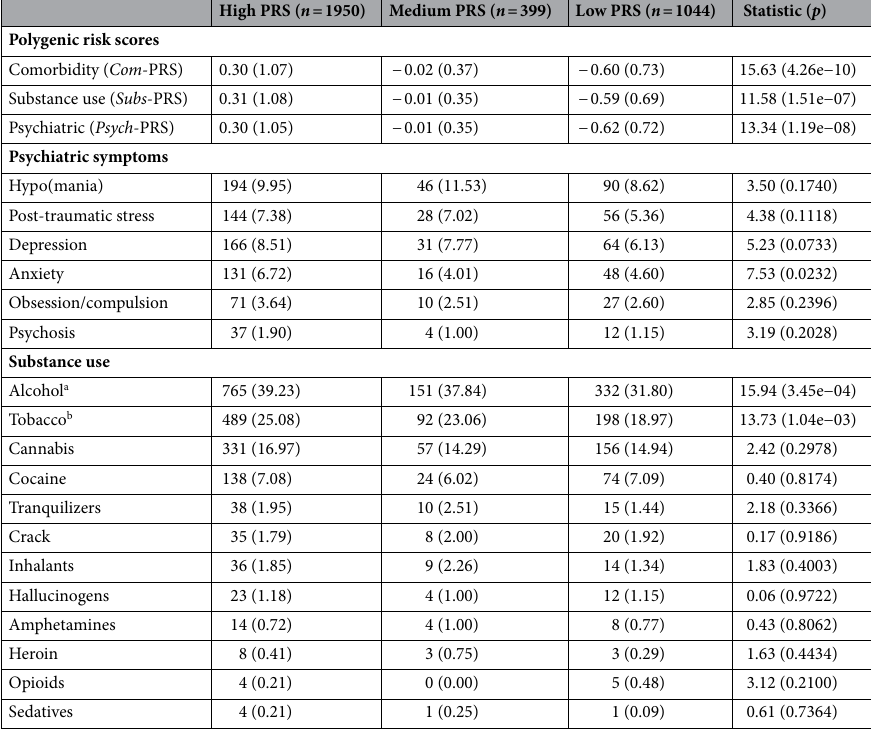
Table 3. Psychiatric symptoms and substance use in the MxGDAR subsample with different PRSs. a Excessive alcohol consumption, b lifetime smoking of at least 100